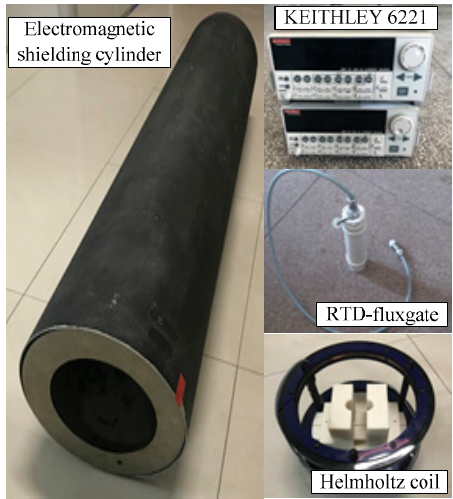
Figure 8. Experimental instruments.